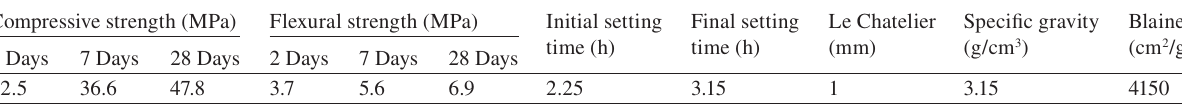
Table 1 Physical and mechanical properties of Portland cement.